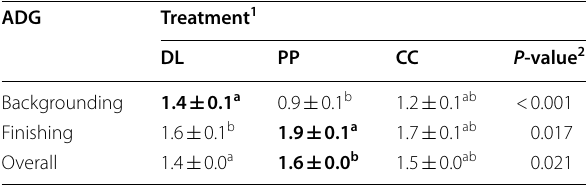
Table 2 Average daily gain (ADG) observed in calves under each backgrounding system at backgrounding, finishing and throughout the